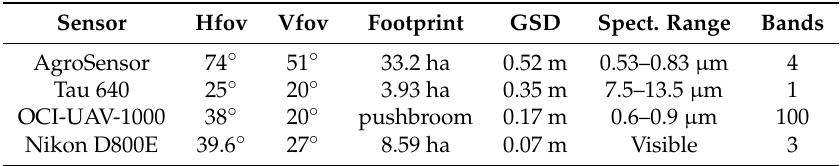
Figure 2. Sensors included in the sensor pod installed on the Cessna C-172 ( a ) Airinov Agrosensor multispectral; ( b ) Tau 640 thermal; ( c ) OCI-UAV-1000 pushbroom hyperspectral; ( d ) Nikon D800E RGB with a Zeiss ZF2 lens. Table 1. Sensor and image parameters when operating at approximately 500 m Above Ground Level including footprint and ground smapling distance (GSD).